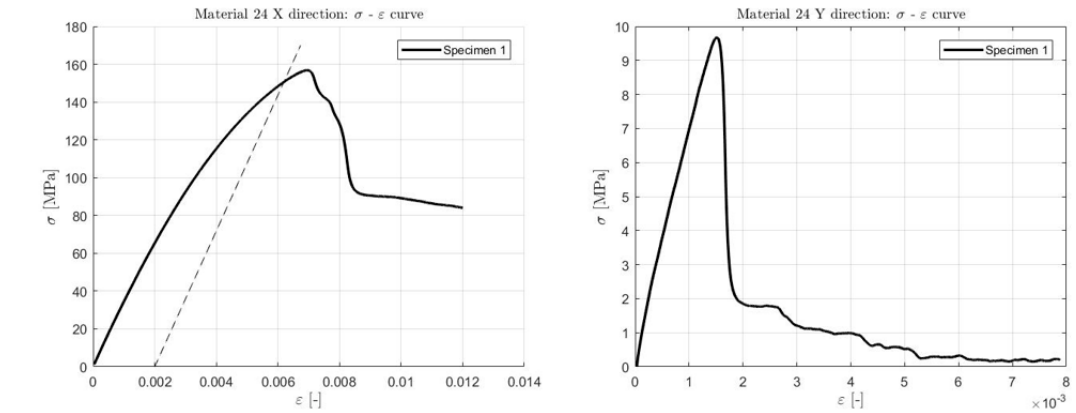
Figure 10. Material 24 tensile tests.